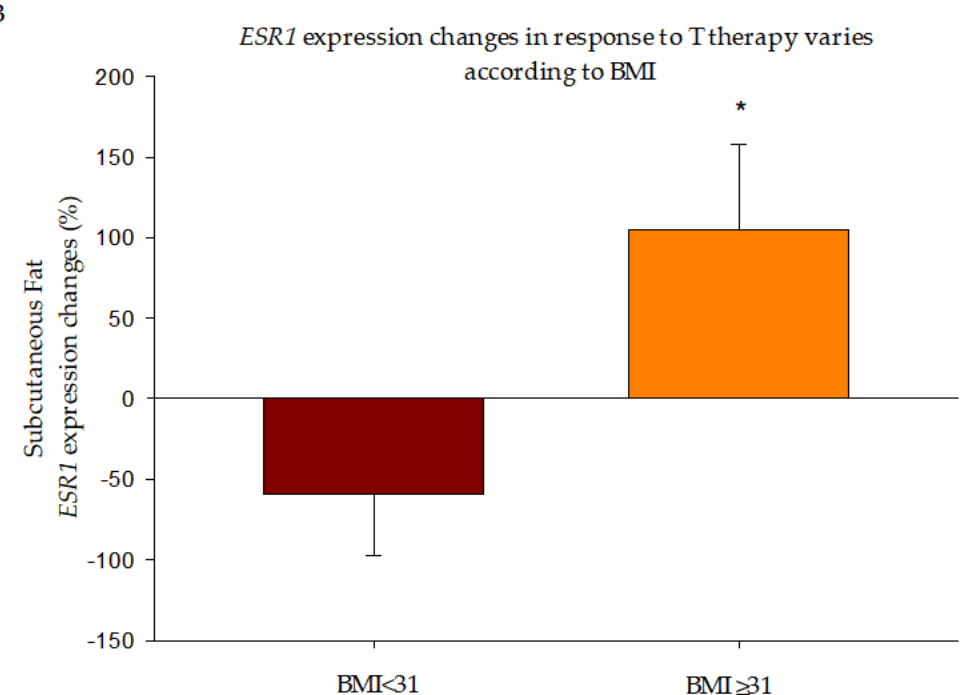
Figure 4. ESR1 expression before and after T therapy varies according to BMI. ESR1 mRNA levels were lower in BMI ≥ 31 ( A ) but increased more in this group after 6 months of T therapy ( B ). Data are presented as Mean ± SE. * p < 0.05 compared to BMI < 31.